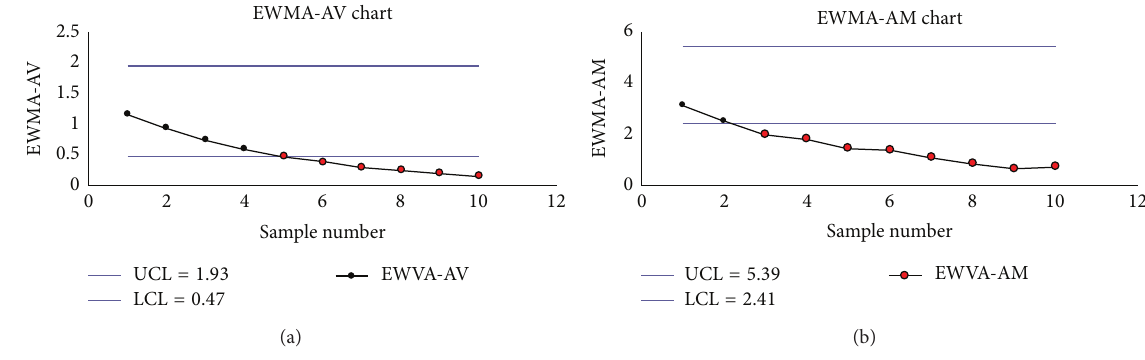
Figure 10: (a) The EWMA-AV chart with 𝜆 2 = 0.2 . (b) The EWMA-AM chart with 𝜆 1 = 0.2